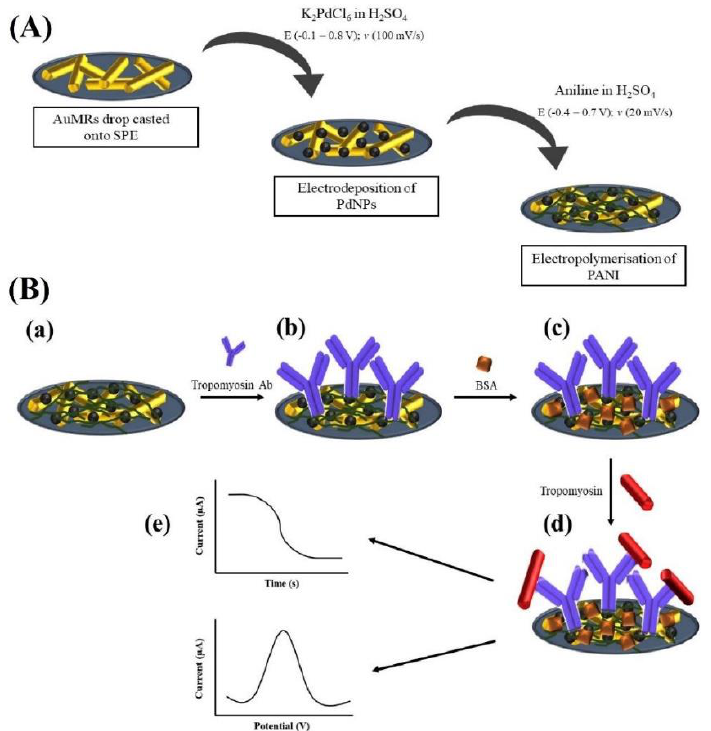
Figure 3. Scheme of the preparation of the SPCE modified with AuMRs/PdNPs/PANI composite and assembly of the TPM immunosensor: ( A ) AuMRs casted onto the working electrode, electrodeposition of PdNPs, and electropolymerization of PANI; ( B ) ( a ) AuMRs/PdNPs/PANI-modified SPCE; ( b ) TPM-Ab functionalized and immobilized onto the modified SPCE after EDC/NHS activation; ( c ) blocking of biosensor surface by BSA; ( d ) addition of different concentrations of TPM; ( e ) electrochemical measurements using CA and DPV techniques. Reprinted with permission from [98].